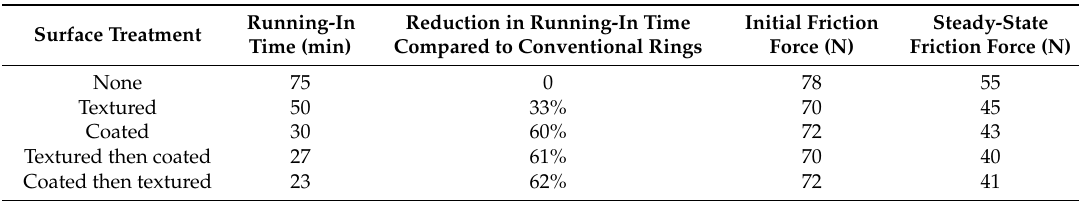
Table 3. A comparison between the running-in behaviors of different ring sets.